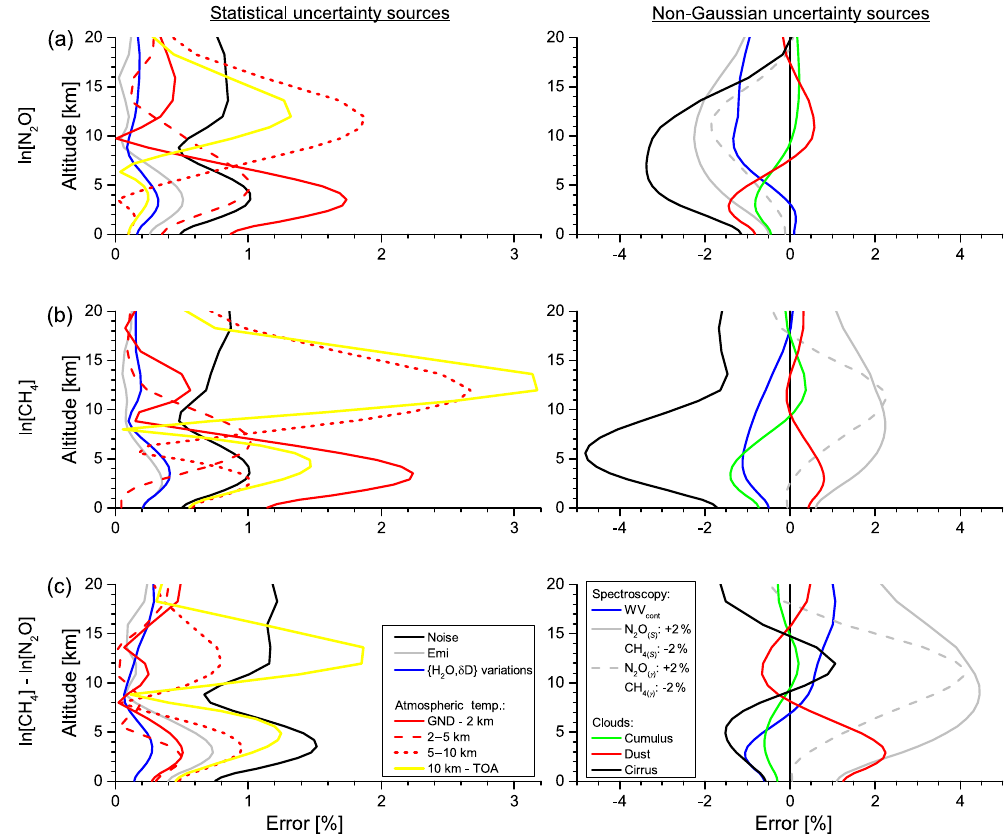
Figure 5. Example of estimated errors for an observation over the mid-latitude site of Lindenberg (52 ◦ N) on 30 August 2008 (same as Fig. 2): (a) for the state vector ln [ N 2 O ] , (b) for the state vector ln [ CH 4 ] and (c) for the state vector ln [ CH 4 ]− ln [ N 2 O ] . The left panels show errors due to statistical uncertainty sources and the right panels errors due to uncertainty sources that are not Gaussian (unrecognized clouds or systematic uncertainty sources like spectroscopic